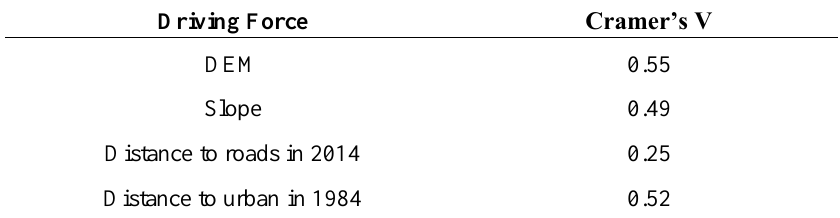
Table 4. Cramer’s V values of the selected driving forces of